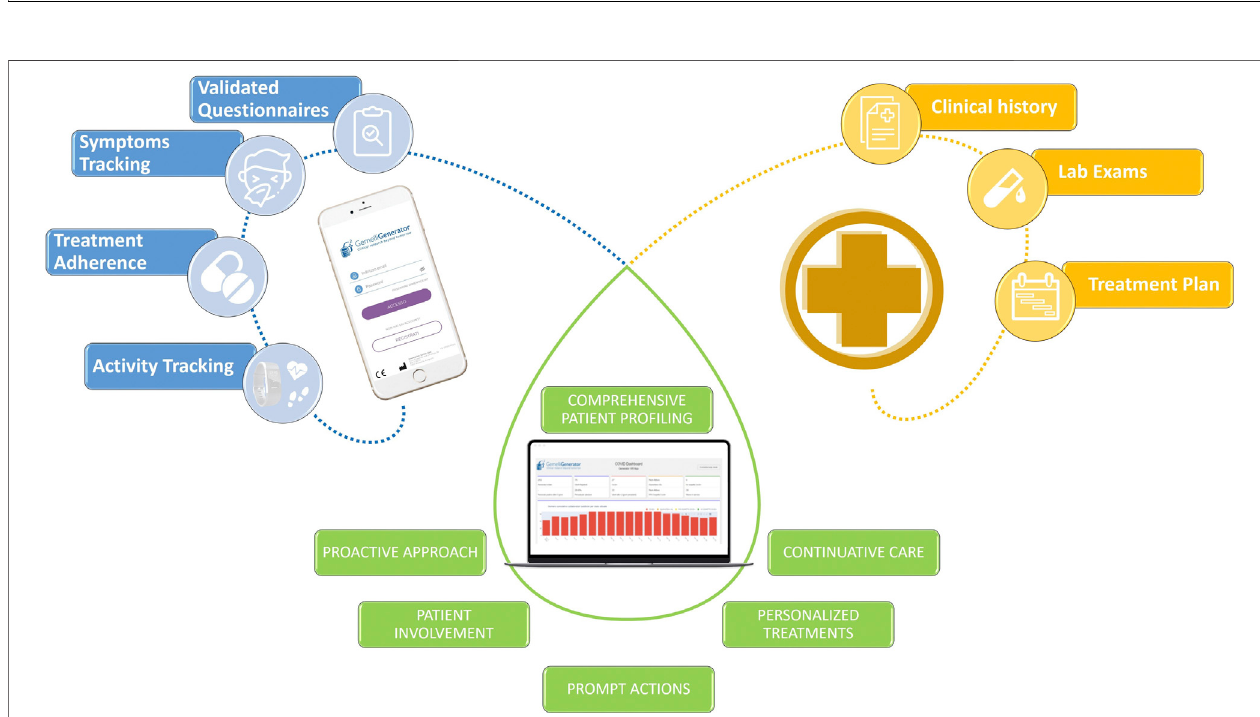
FIGURE11| Exampleoftheintegrationofheterogeneousdatawiththeaimofofferinginnovativeandmoreef fi cientpatientservicesthroughtheuseofdigitaltools.